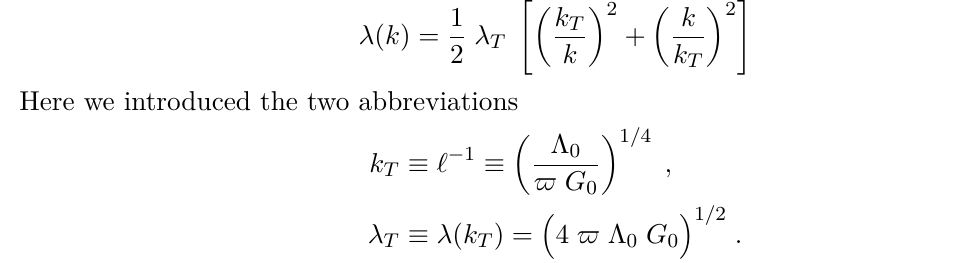
JHEP08(2022)040